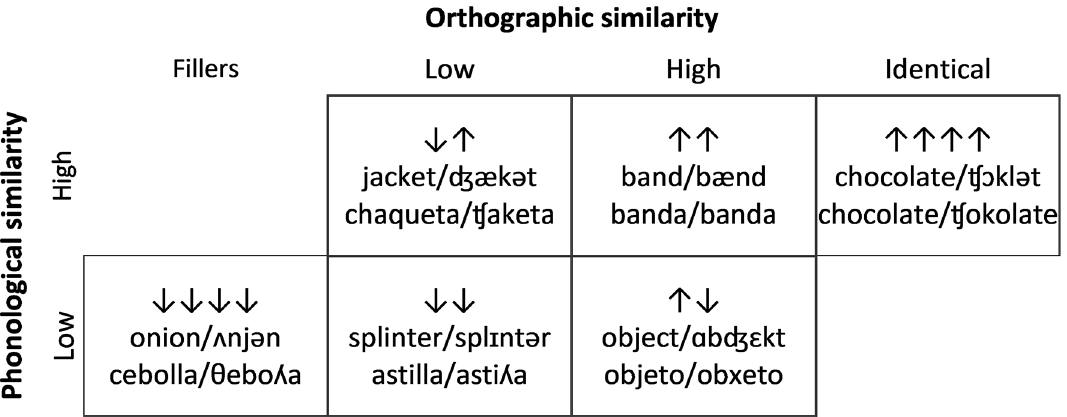
Figure 1. Orthographic and phonological similarity distribution and examples of words in each category. The reported phonological transcriptions correspond to a general American English accent, which is the accent of the speaker who recorded the stimuli. Pseudowords were recorded to match the IPA transcription rather than the orthography of the pseudoword. All transcriptions were verified by a linguist to match the stimuli. Each row represents a level of phonological similarity and each column represents a level of orthographic similarity. Each cell contains 50